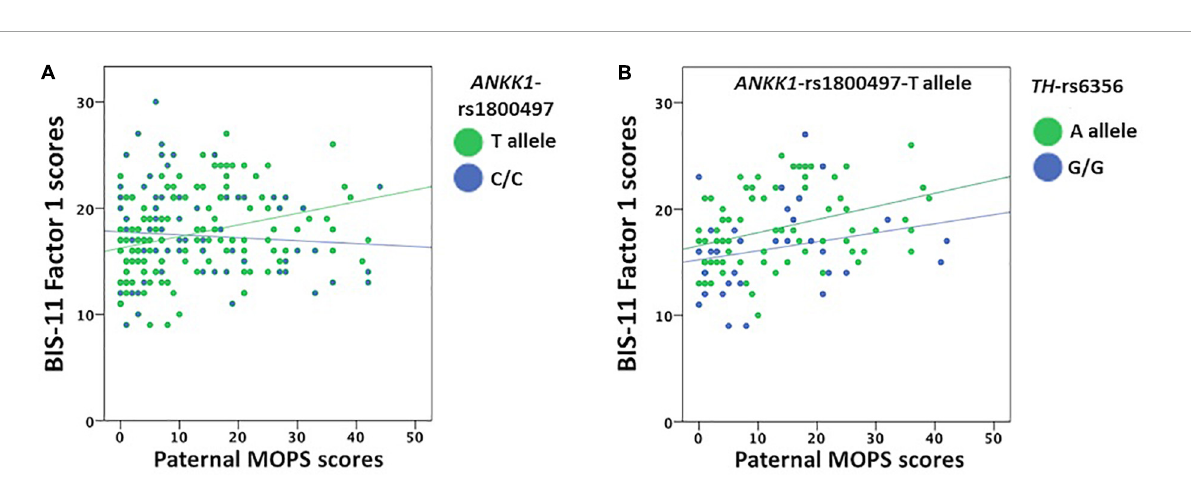
FIGURE3 Correlation between BIS-11 cognitive/attentive (Factor 1) and Paternal MOPS scores divided by ANKK1 -rs1800497 genotype groupings and in ANKK1 -rs1800497-T allele carriers divided by TH -6356 genotype groupings. (A) In ANKK1 -rs1800497-T allele carriers, Paternal MOPS scores positively correlated with BIS-11 cognitive/attentive scores. (B) Among ANKK1 -rs1800497-T allele carriers, Paternal MOPS scores positively correlated with BIS-11 cognitive/attentive scores in TH -rs6356-A allele